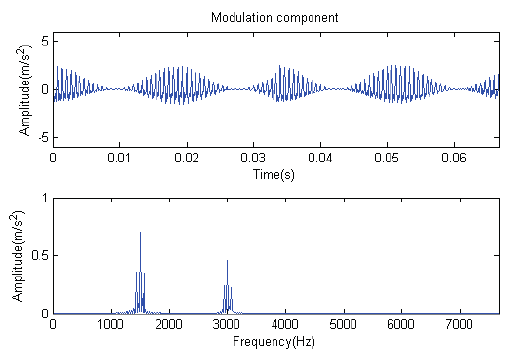
Figure 23. Modulation